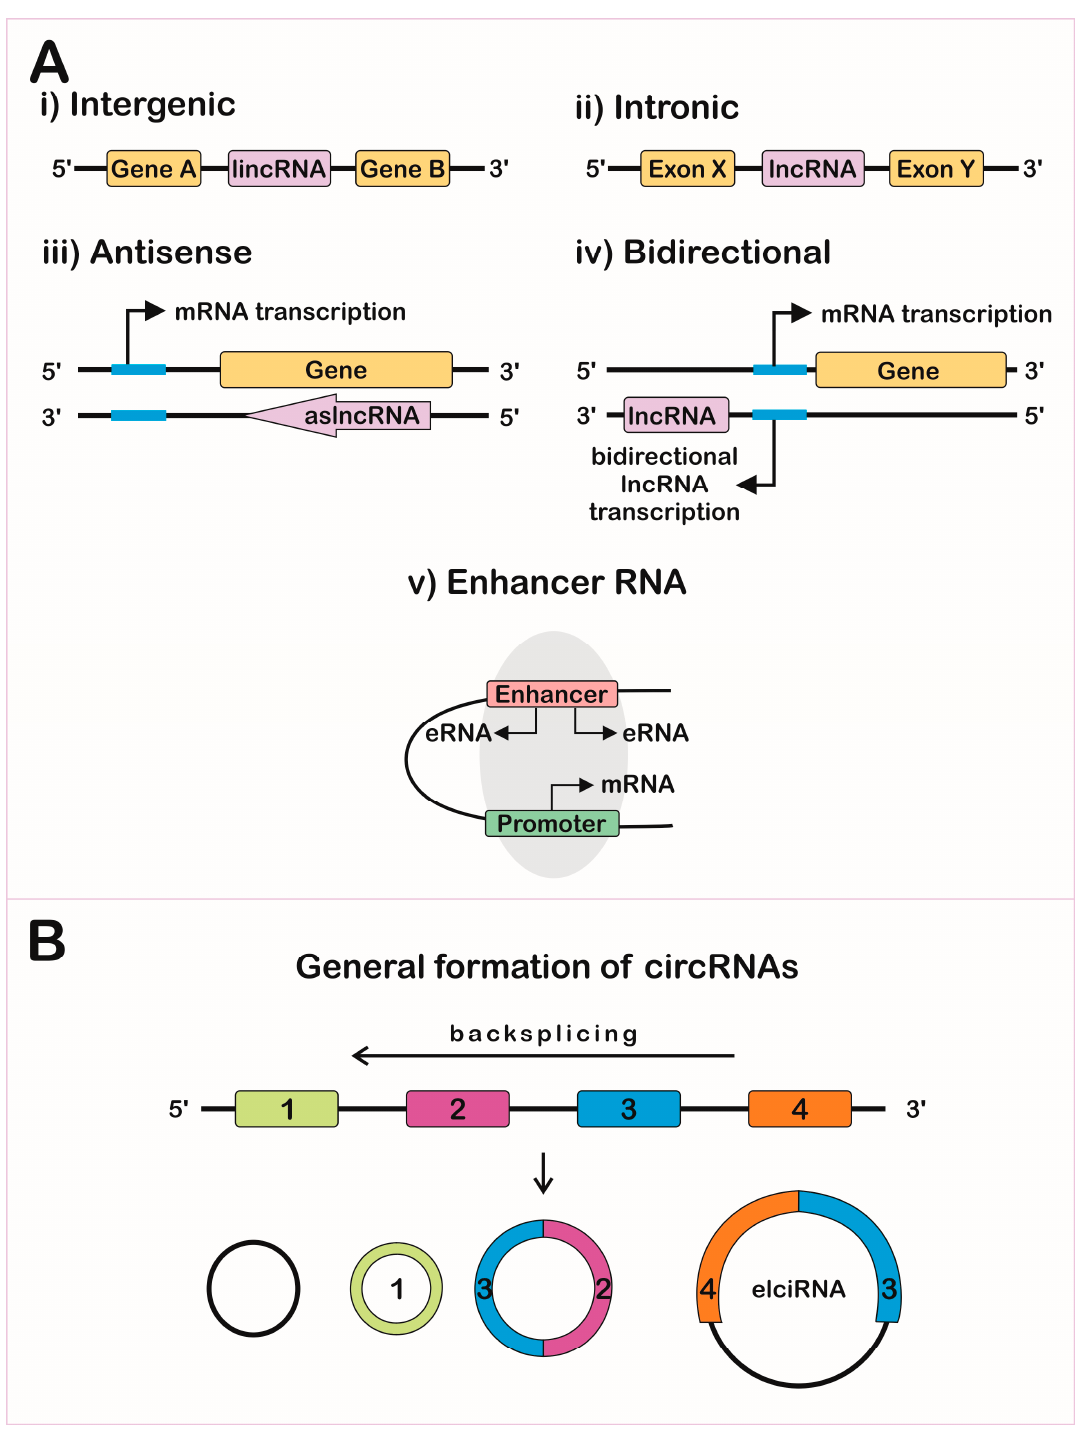
Figure 1. Schematic representation of the genomic loci of different long non-coding RNA (lncRNA) and circular RNA (circRNA) biogenesis. ( A ) lncRNA classification depends on the genomic position: (i) intergenic RNAs (lincRNAs) are located between two protein coding-genes, (ii) intronic lncRNAs are positioned within an intronic region of a protein coding-gene, (iii) antisense lncRNAs (aslncRNAs) are transcribed from complementary strands, (iv) bidirectional lncRNAs originate from bidirectional transcription of protein-coding genes, and (v) enhancer RNAs (eRNAs) originate from enhancer regions and mediate transcription factor positioning into protein coding-genes promoters. ( B ) circRNAs are lncRNAs that undergo back splicing and can originate from transcripts containing only intronic, one or more exonic, or both intronic and exonic fragments